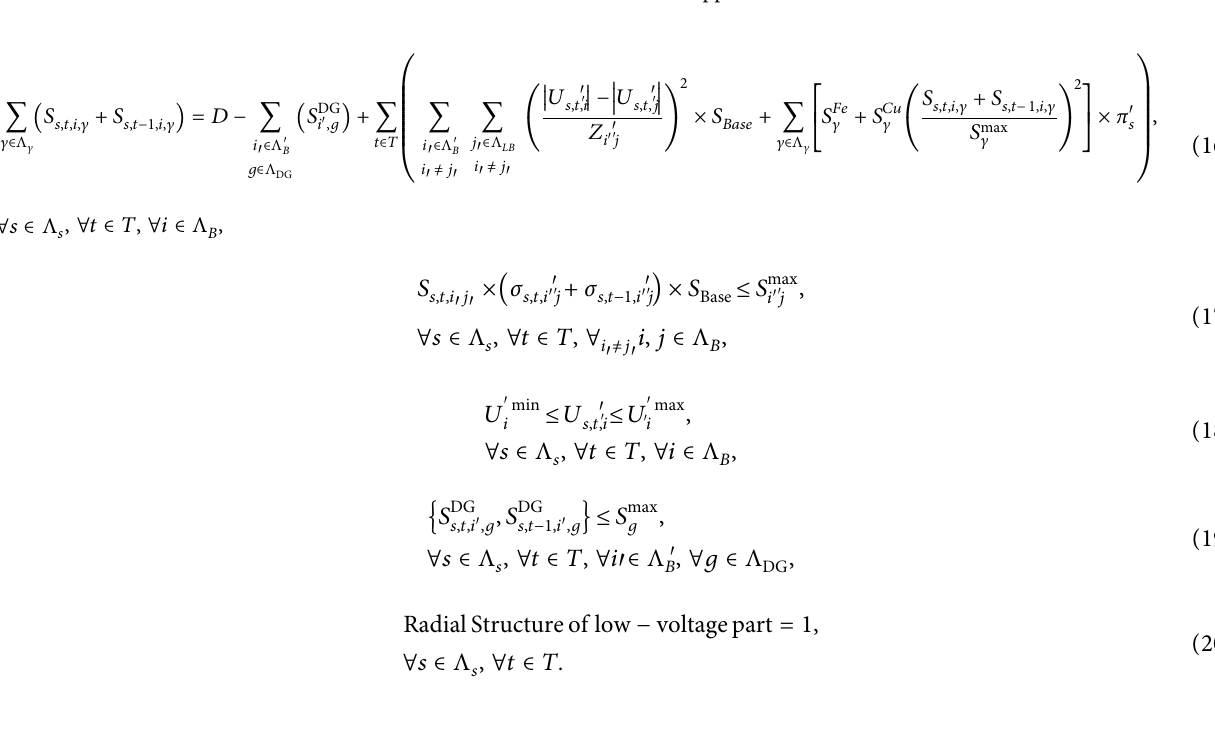
Figure 3: Pseudocode of the applied